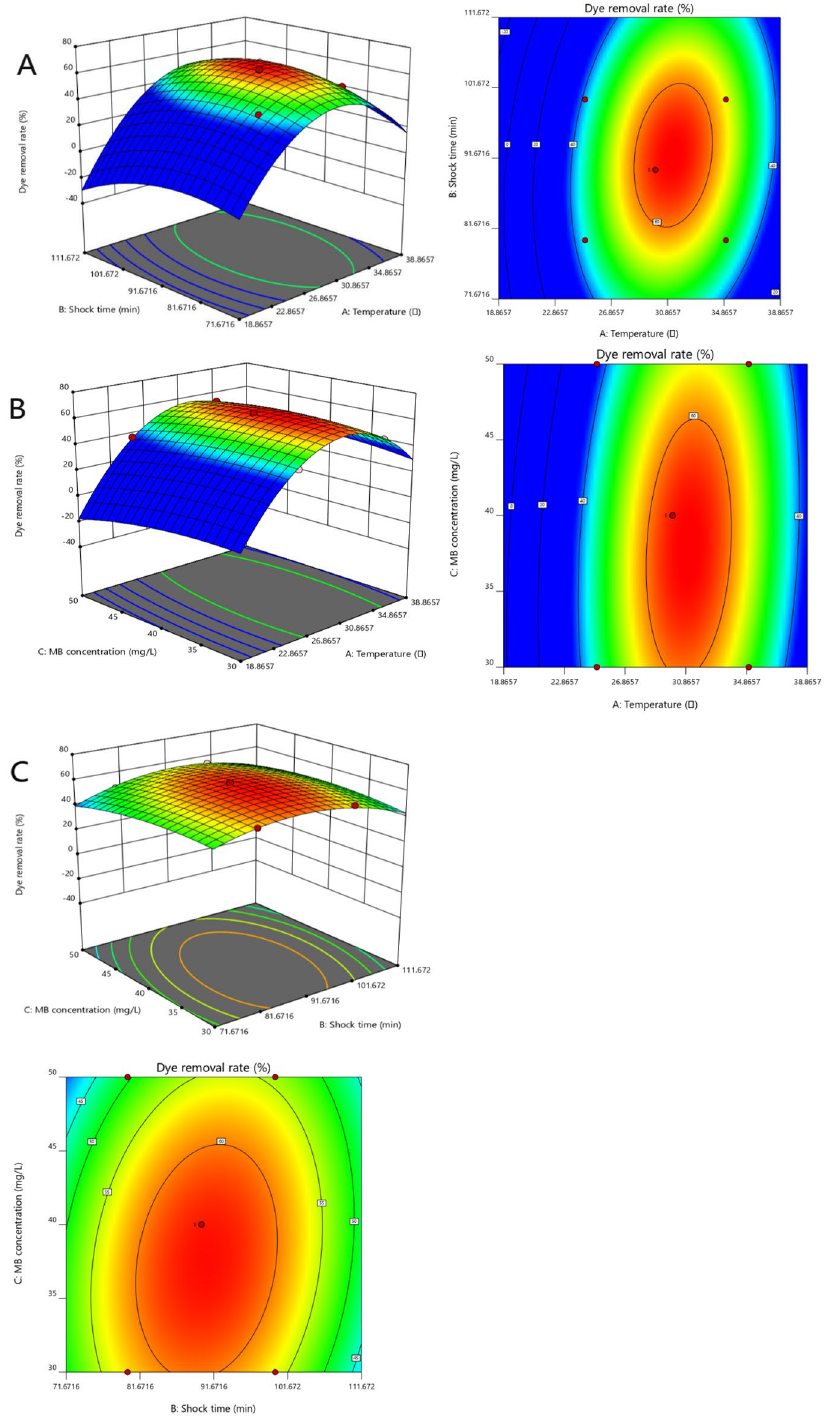
Figure 10. Response surface plot and contour plot of the influence of Various factors on removal rate (( a ): Temperature and Shock time; ( b ): MB concentration and Temperature; ( c ): MB concentration and Shock